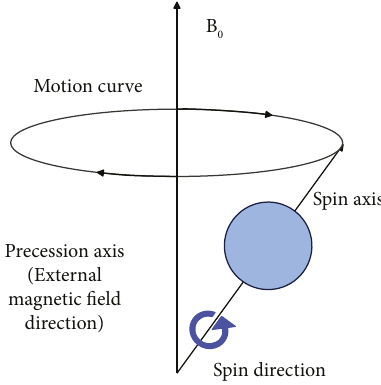
Figure 2: Precession of photons in an external magnetic field.